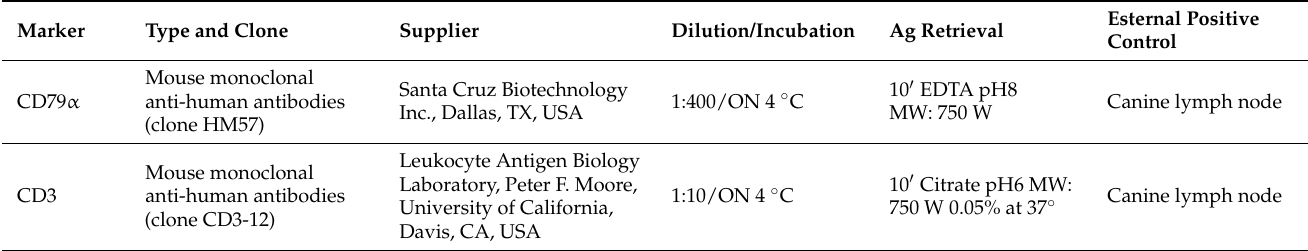
Table 1. Immunohistochemistry, materials, and